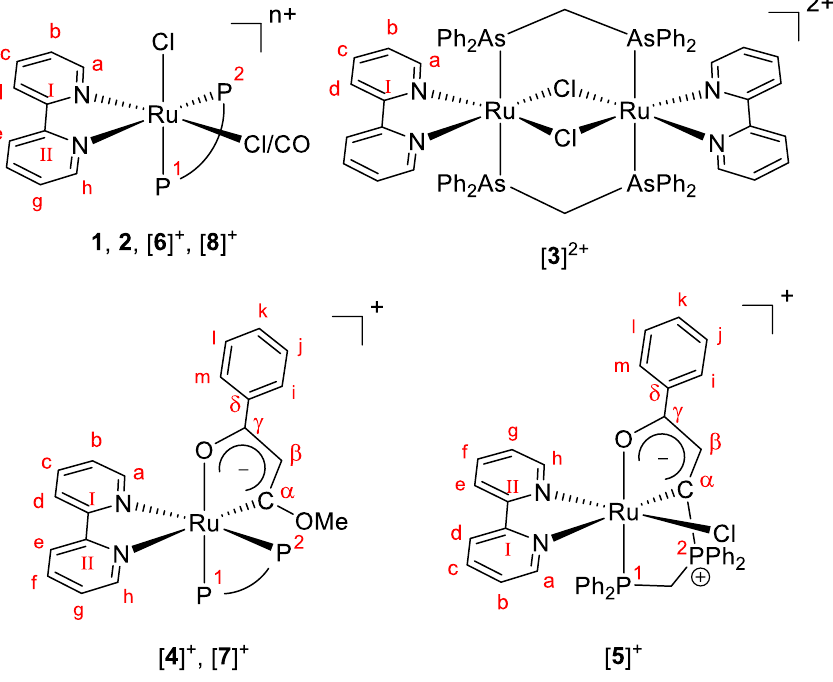
Figure 4. Labeling scheme for H, C and P atoms in this work.